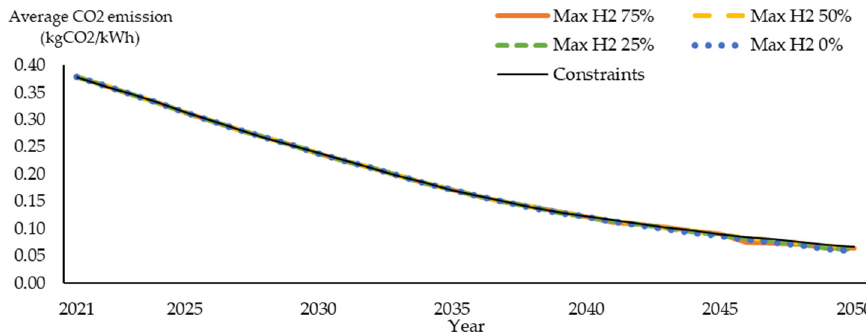
Figure 20. Average electricity cost comparison.